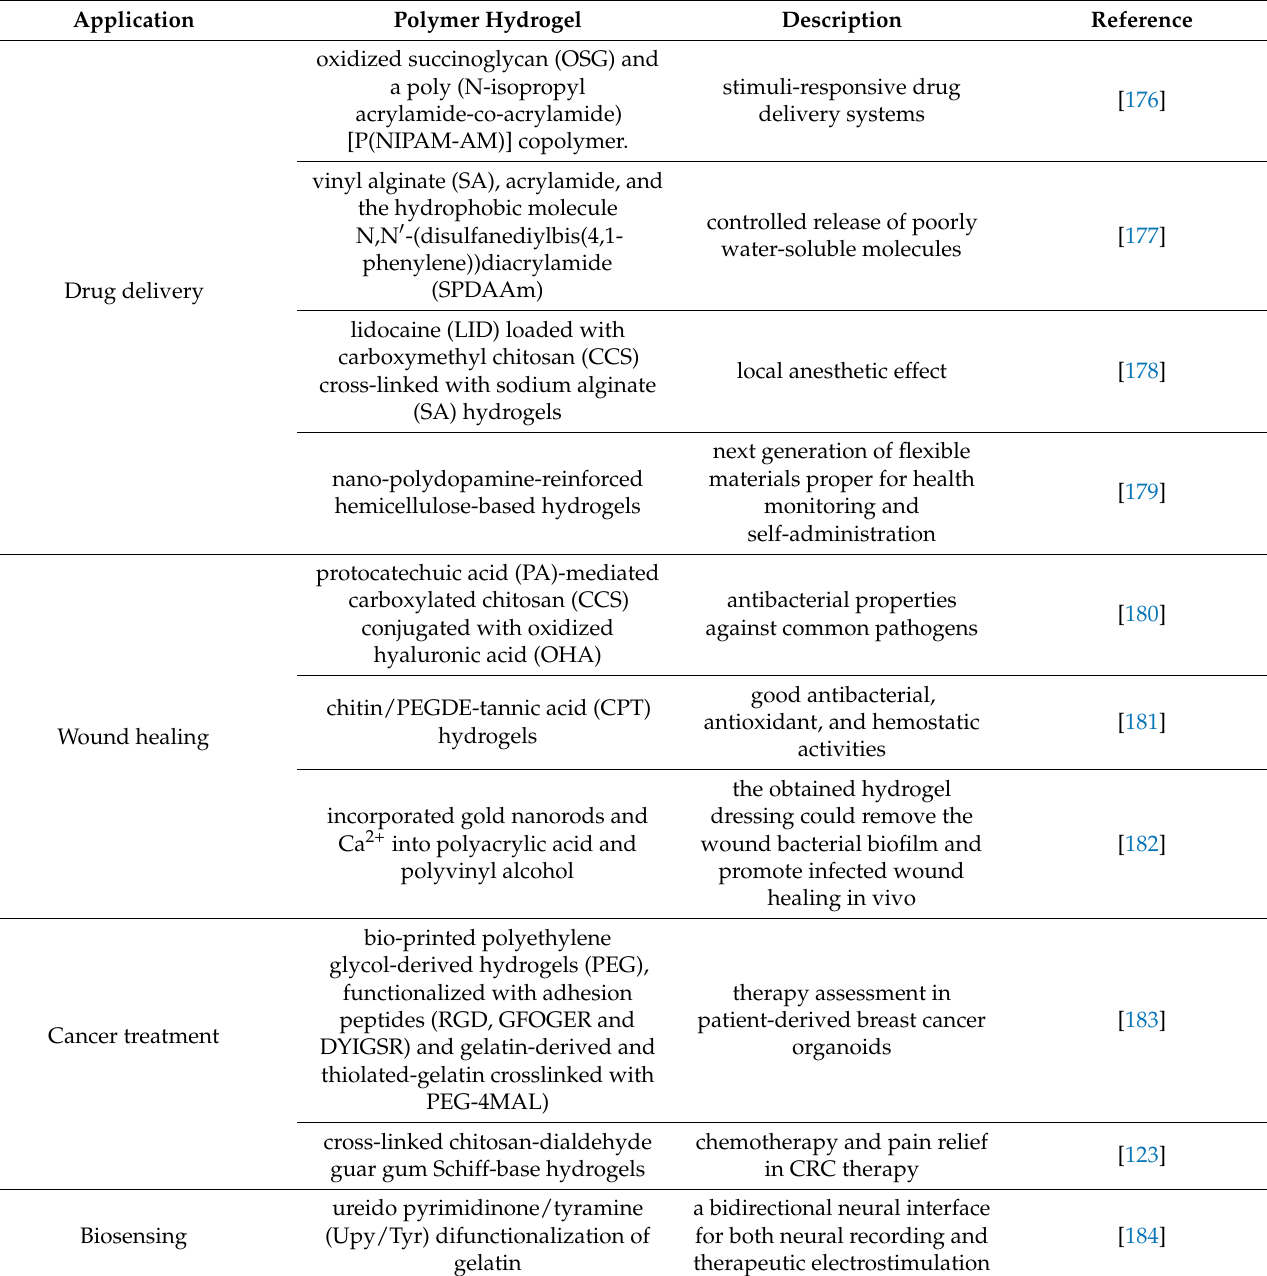
Table 3. Most recent biomedical applications of polymer